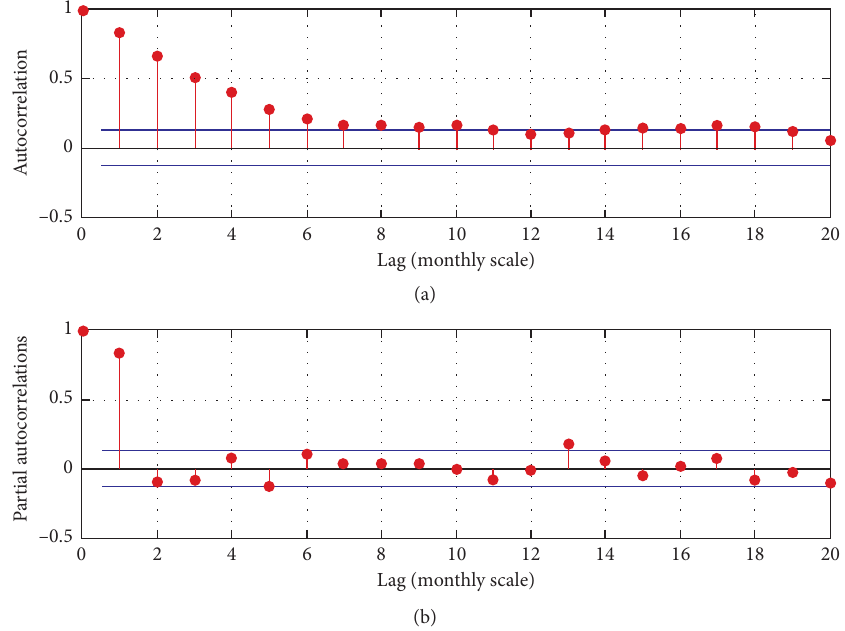
Figure 7: The statistical correlation process function of the investigated monthly scale river